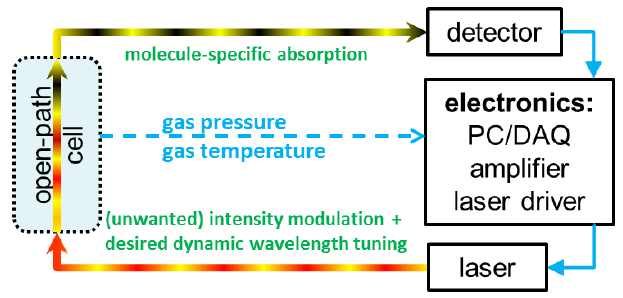
Figure 1. TDLAS principle and basic setup: the laser current mod- ulation at typically 100Hz–10kHz initiates a rapid wavelength tun- ing in combination with a strong intensity modulation of the diode laser radiation. The molecule-specific light loss caused by the ab- sorbers within the open-path cell is captured for each individual wavelength scan by a photodetector, digitised, and saved as raw data for subsequent data